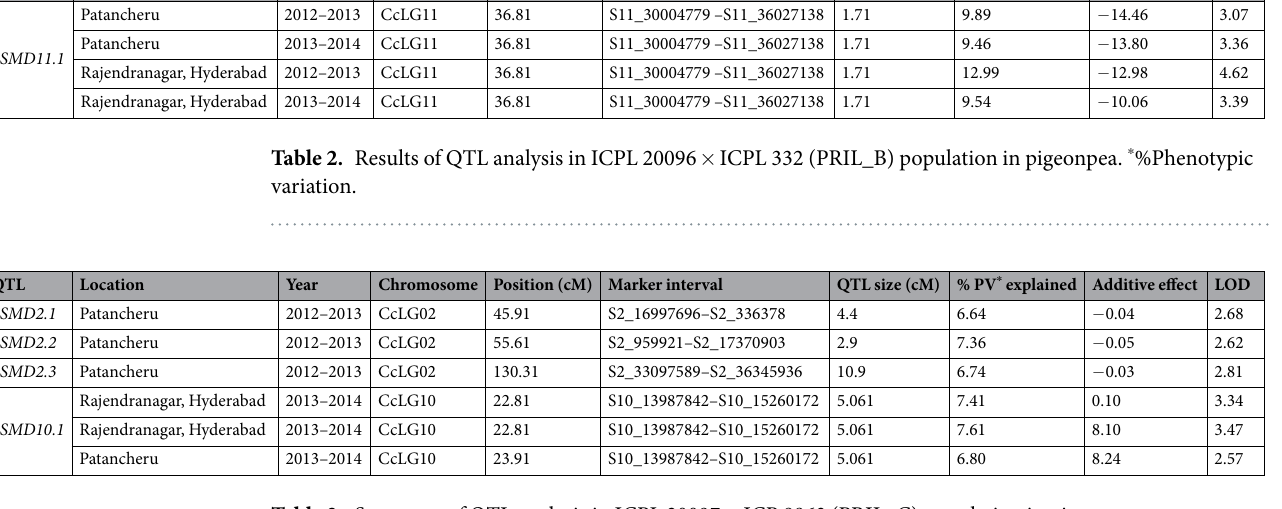
Table 3. Summary of QTL analysis in ICPL 20097 × ICP 8863 (PRIL_C) population in pigeonpea. * %Phenotypic variation.